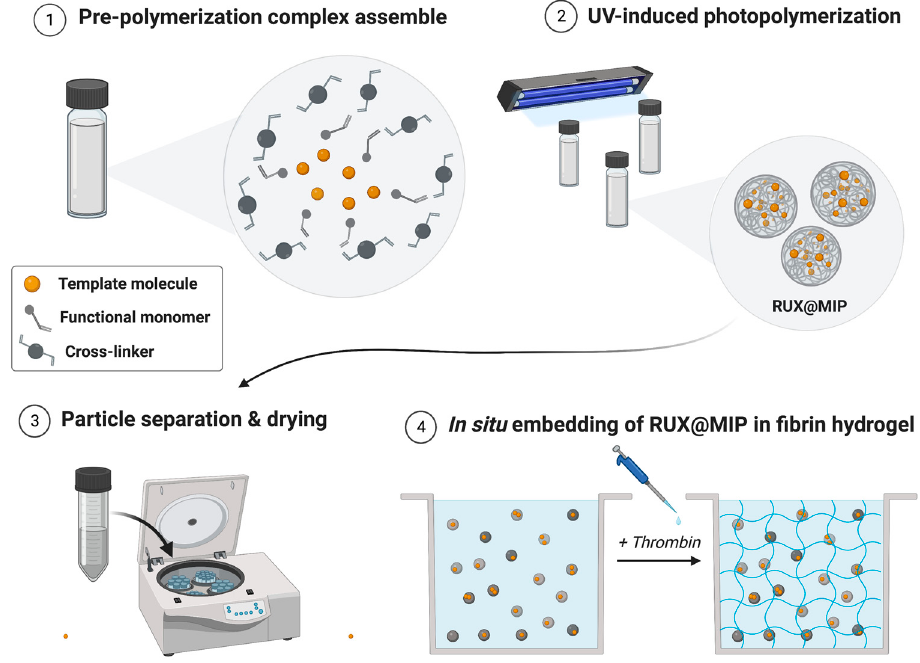
Figure 2. Schematic illustration of the fabrication process for the MIP-based DDS embedded in fibrin hydrogel. MIP synthesis starts with the assembly of a pre-polymerization complex using RUX, func- tional monomer, and crosslinker. After the UV-induced photopolymerization (24 h), RUX@MIP par- ticles are separated by centrifugation and dried. MIP powder is the suspended in a fibrinogen solu- tion, and the final DDS is obtained after adding thrombin to form a fibrin network; RUX@MIP = RUX-loaded MIPs. Created with BioRender.com.